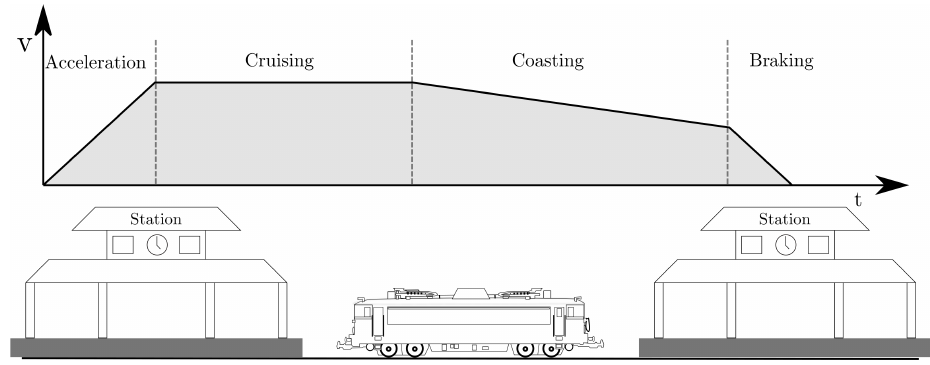
Figure 1. Driving regimes associated to the